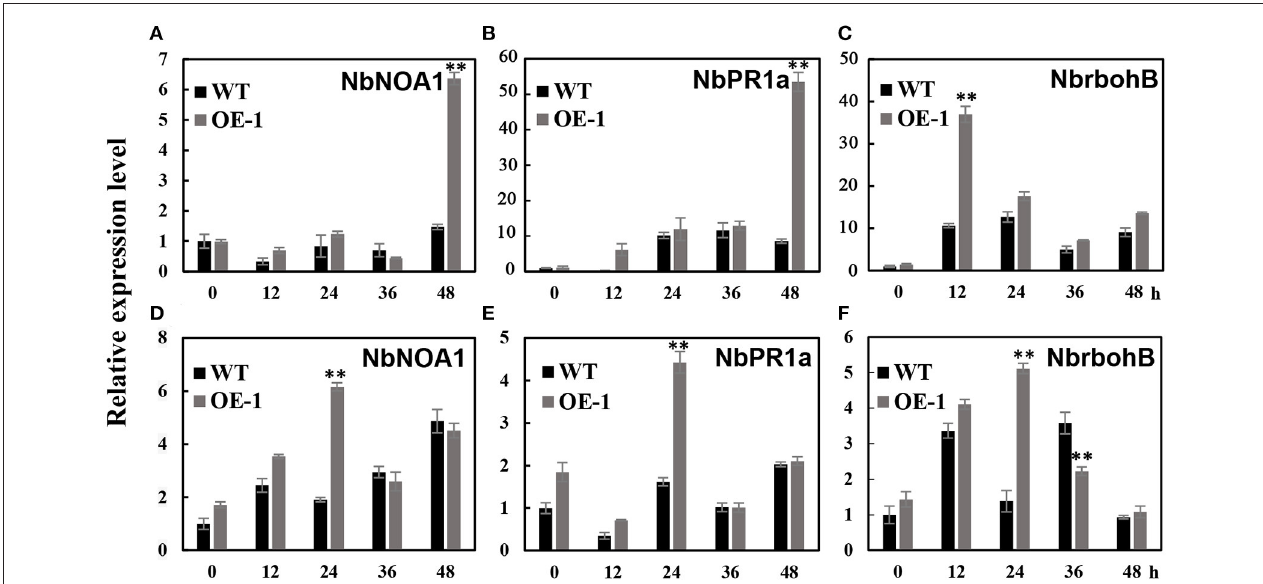
FIGURE 5 | Different effects of the gene expression after A. alternate and C. nicotianae Averna infection between wild-type (WT) and AtMYB12 overexpression tobacco (OE-1). (A) Relative expression analysis of NbNOA1 after inoculation with the A. alternata isolate, which was performed 0, 12, 24, 36, and 48h post-inoculation. The values represent the average of three technical replicates, and are the means ± SD ( n = 3, * p < 0.05, ** p < 0.01). (B) Relative expression analysis of NbPR1a after inoculation with the A. alternata isolate. (C) Relative expression analysis of NbrbohB after inoculation with the A. alternata isolate. (D) Relative expression analysis of NbNOA1 after inoculation with C. nicotianae Averna. (E) Relative expression analysis of NbPR1a after inoculation with C. nicotianae Averna. (F) Relative expression analysis of NbrbohB after inoculation with C. nicotianae